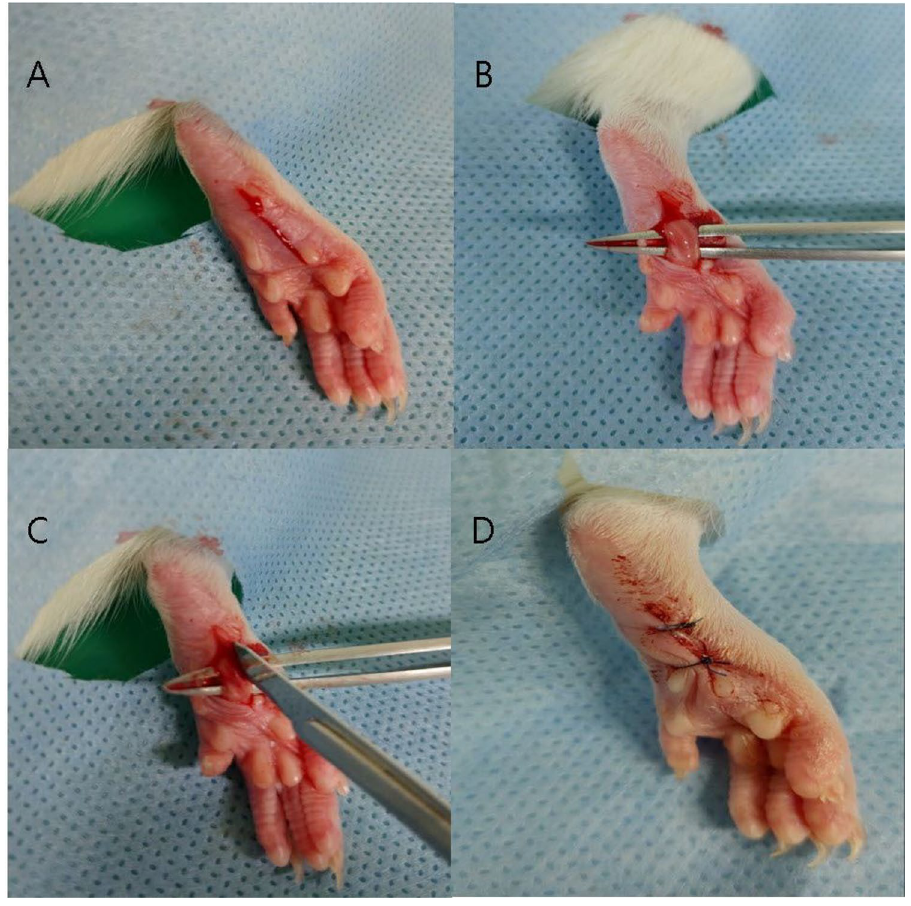
Figure 4. Incisional pain model preparation. ( A ) Skin incision was made on the plantar area of the hind paw. ( B ) The plantaris muscle was elevated. ( C ) An incision was made longitudinally, keeping the muscle origin and insertion site intact. ( D ) The incision was closed with two interrupted horizontal mattress